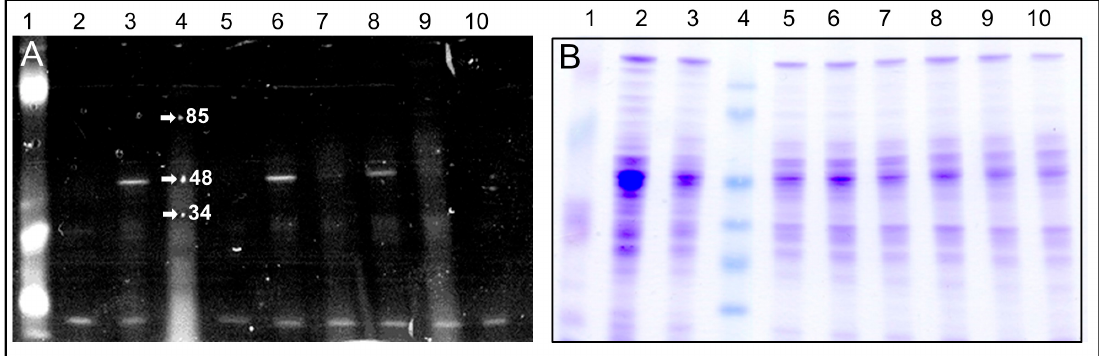
Figure 5. Images of the gels after SDS electrophoresis of solubilized mitochondria exposed to C4R1 or C12R1 under different conditions. ( A ), fluorescence; ( B ), the same gel stained with Coomassie blue. Lanes: 1. MW fluorescent markers; 2. RLM 40 μ g; 3. RLM+C4R1 (5 μ M); 4. MW markers; 5. RLM; 6. RLM+C4R1 (5 μ M); 7. RLM+C12R1 (5 μ M); 8. RLM+ C4R1(5 μ M) + T3 (20 μ M); 9. RLM+C4R1 (5 μ M)+T3 (20 μ M); 9. RLM+T3 (20 μ M); 10. RLM. Note the low MW autofluorescence band on the bottom of the gel supporting equal protein loading in wells.